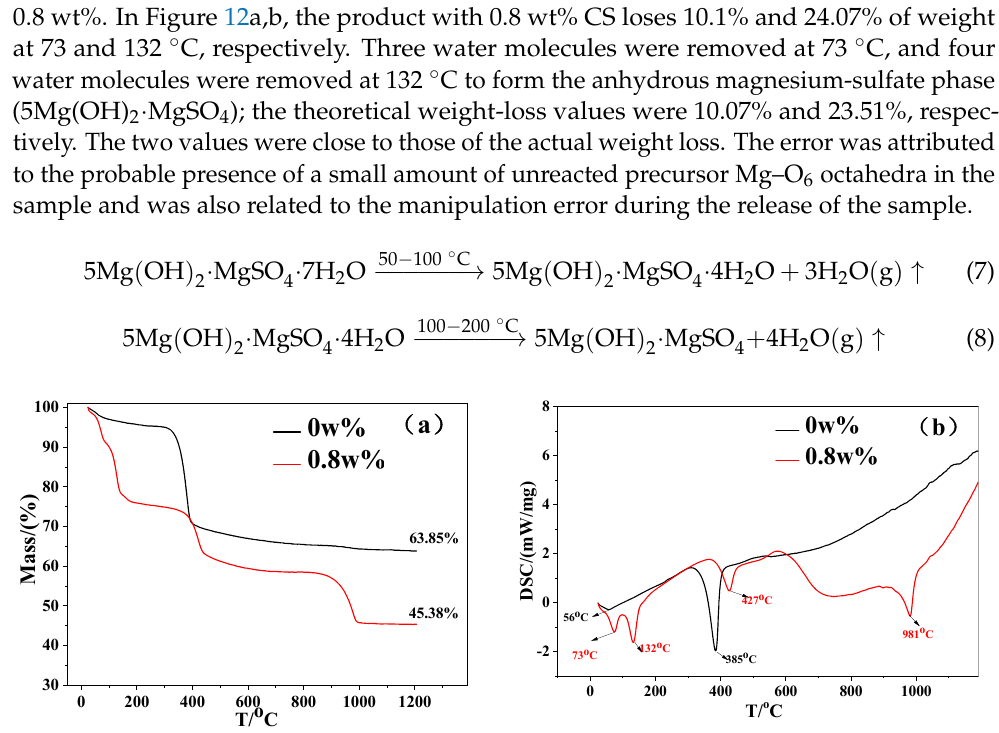
Figure 12. TG ( a ) and DSC ( b ) curves of each sample.